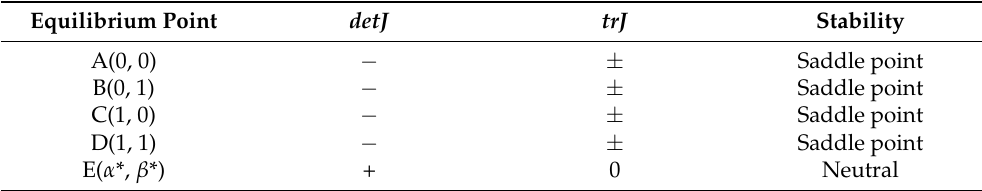
Table 4. Local stability analysis of scenario 2 between local government and coal-related enterprises. Equilibrium